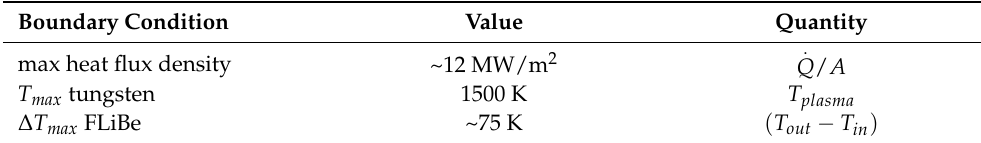
Table 2. Boundary conditions of vacuum vessel cooler [4].